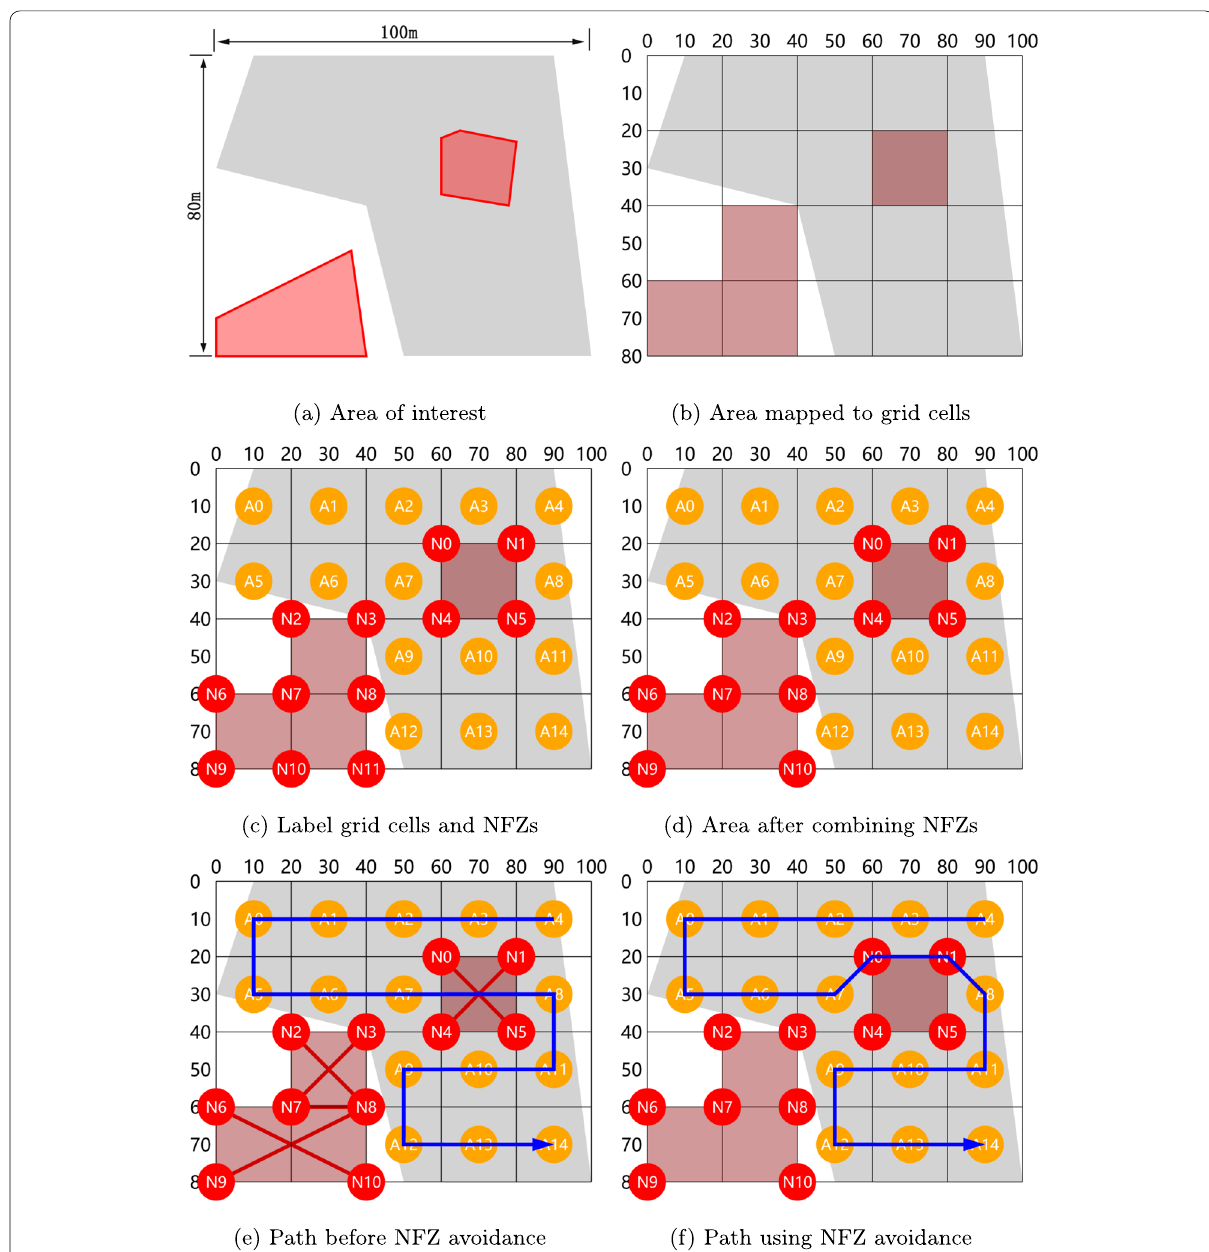
Fig. 1 Grid-based area decomposition and cells